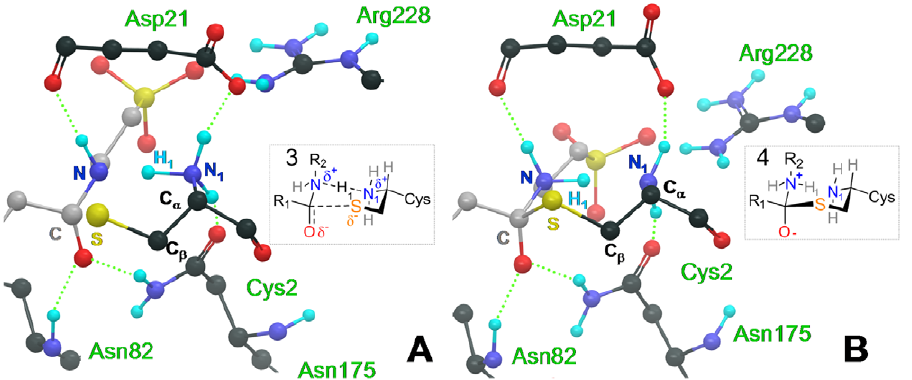
Figure 7. Transition state (TS) and tetrahedral adduct (TA) geometries identified along the path. Left panel (A). TS structure of TAU (gray carbons) hydrolysis catalyzed by CBAH (black carbons). H 1 is nearly equidistant between N and N 1 favoring the formation of a pseudo chair structure. Right panel (B) Zwitterionic TI. In both panels, H-bonds are shown as dotted green lines, while secondary structure elements of CBAH are omitted for